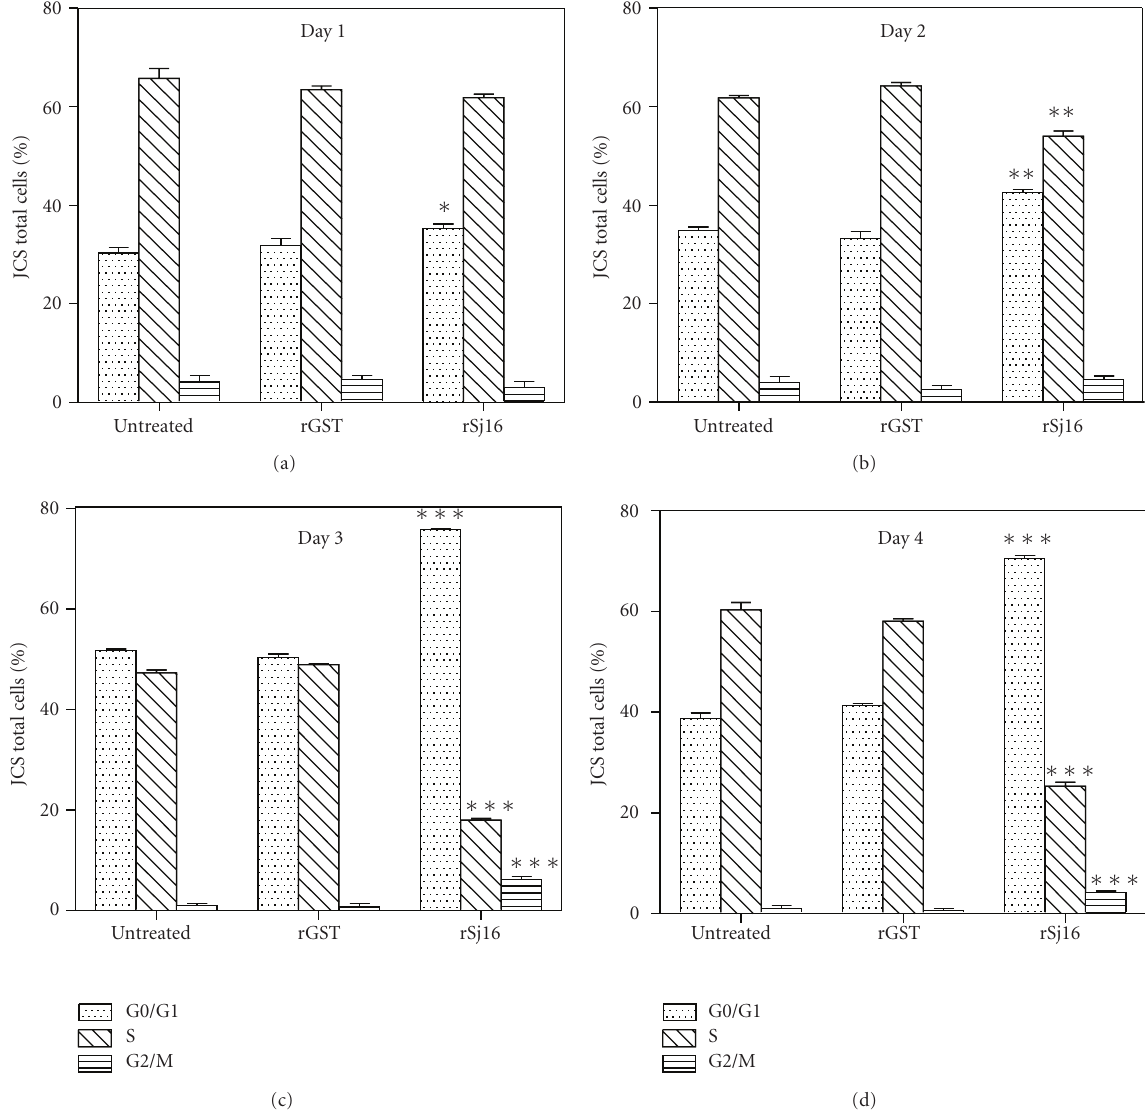
Figure 2: Modulation of WEHI-3B JCS cell cycle by rSj16. WEHI-3B JCS cells were cultured for one day (a), two days (b), three days (c), and four days (d) in the presence of 0.5 μ g/ml of rSj16 ( rSj16 ), 0.5 μ g/ml of rGST ( rGST ), or medium alone ( untreated ), and the cell cycle status was analyzed by flow cytometry. Data indicate mean ± SEM of three independent experiments. ∗ P < . 1; ∗∗ P < . 01; ∗∗∗ P < . 001 as compared with that of untreated